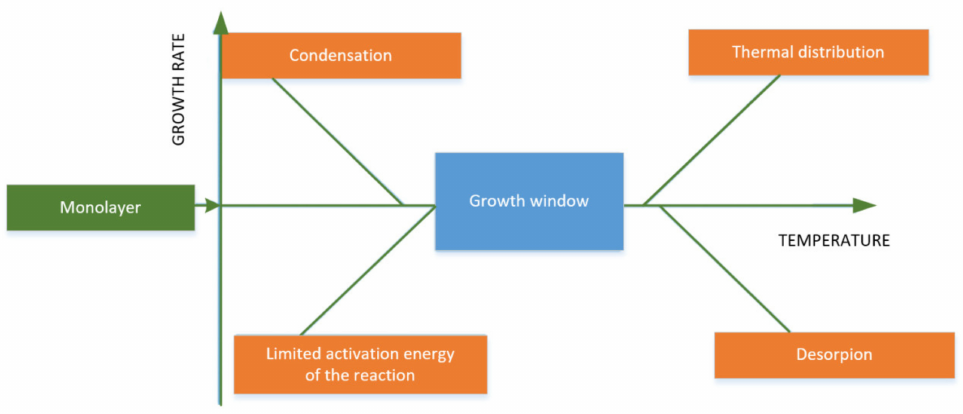
Figure 6. Temperature dependence of layer growth rate